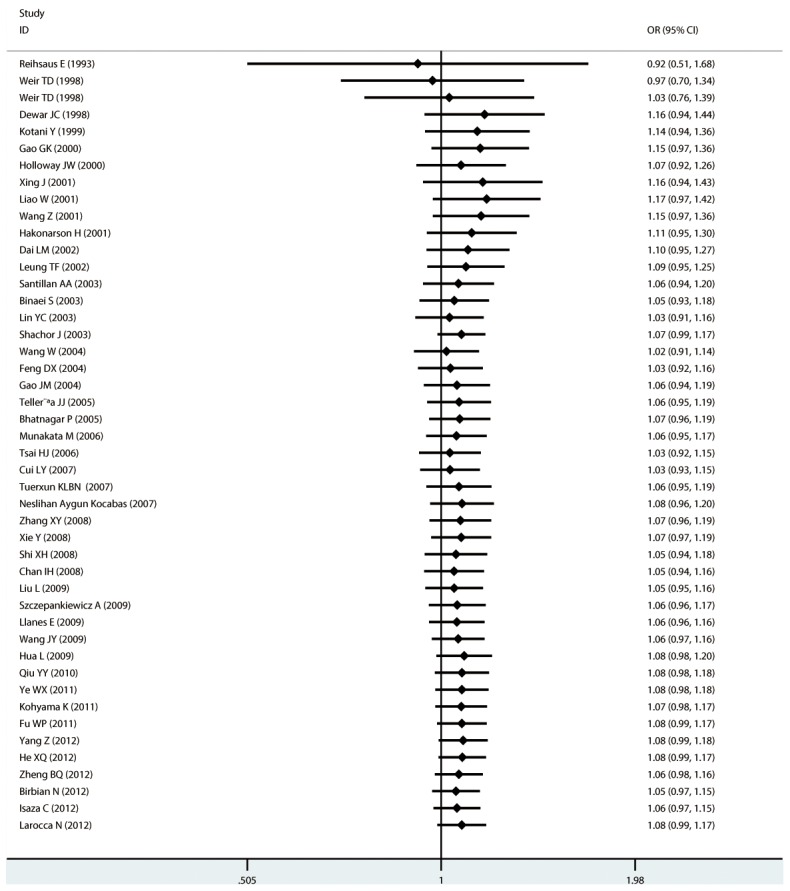
Forest plots of cumulative meta-analysis of Arg16Gly (rs1042713) in association with asthma by published year under allele comparison.